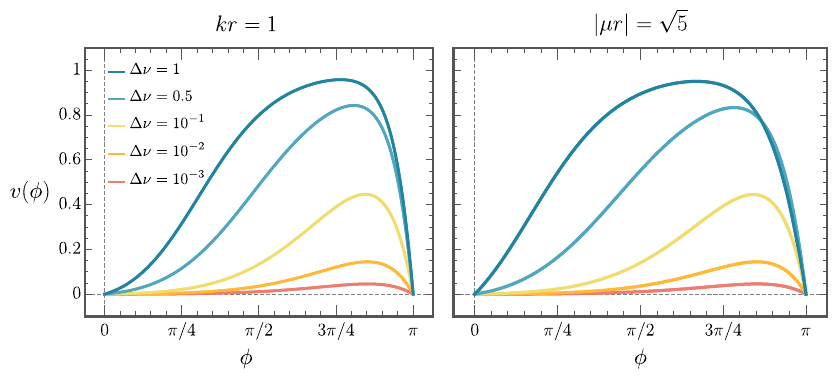
Figure 3 . Solutions for the scalar VEV v ( (cid:30) ), with (cid:30) = (cid:25) and (cid:12)xed values of kr (left) and